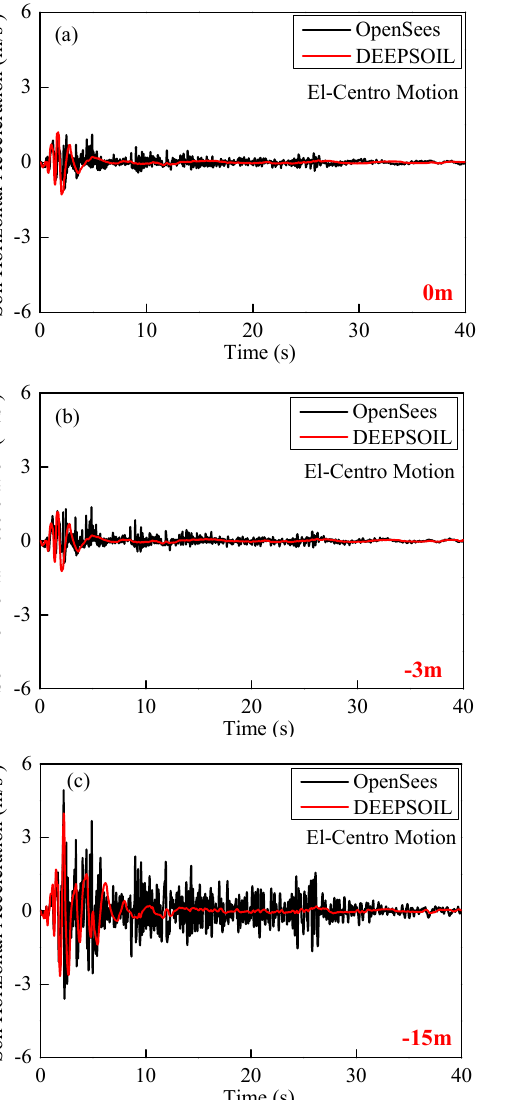
Figure 14. Development of excess pore pressure ratios: ( a ) −3 m; ( b ) −15 m under the El-Centro motion and ( c ) −3 m; ( d ) −15 m under the Kobe Motion.